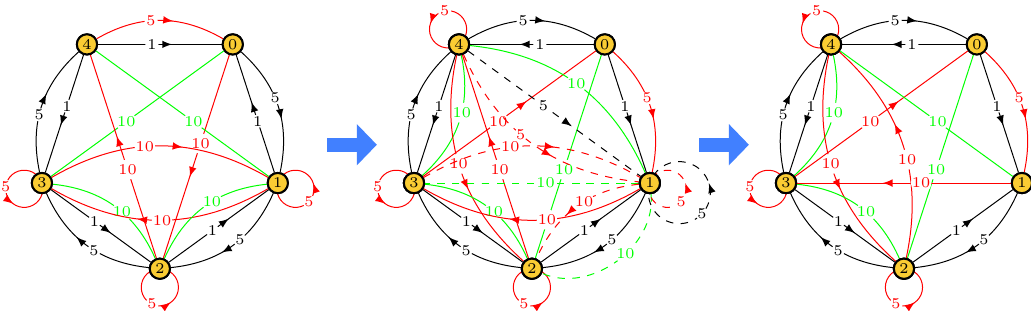
Figure 8. a) Quiver diagram for Y 1 ; 0 ( P 4 ). b) Result of the mutation on node 0. Massive (cid:12)elds are represented by dashed arrows. c) After integrating out massive (cid:12)elds, we obtain the original quiver, up to an i i 1 cyclic relabeling of the nodes. This translates into a clockwise rotation ! (cid:0) of the